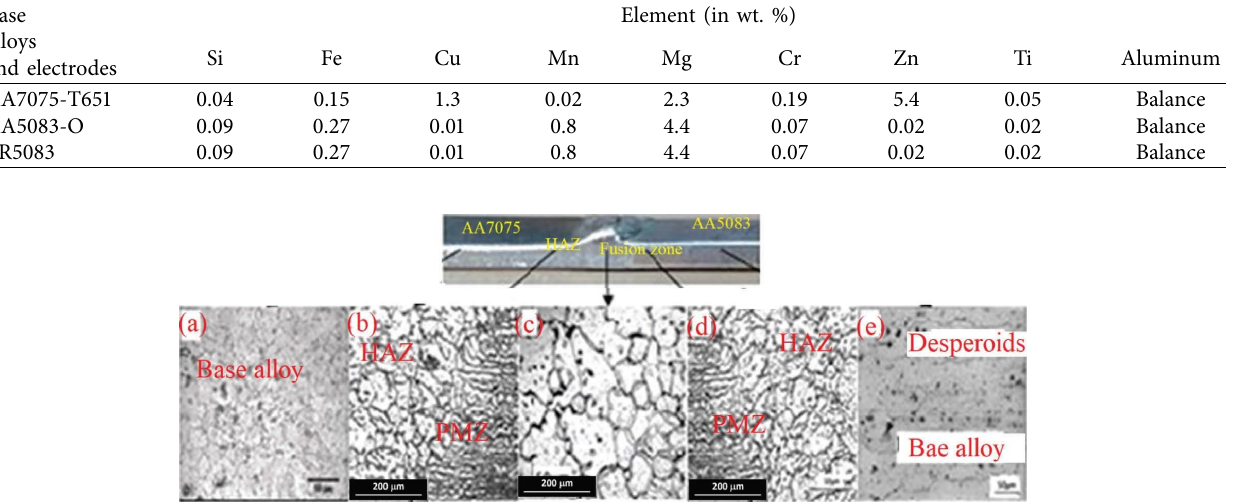
Figure 1: Macrosection of weld joint fabricated at 100amp.